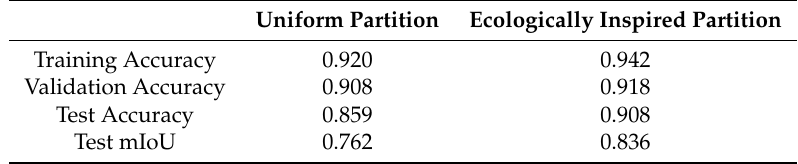
Table 2. Model performance choosing the training/validation areas uniformly or according to the ecologically inspired partition. Test set is always the red area at the bottom of the map (see Figure 3).